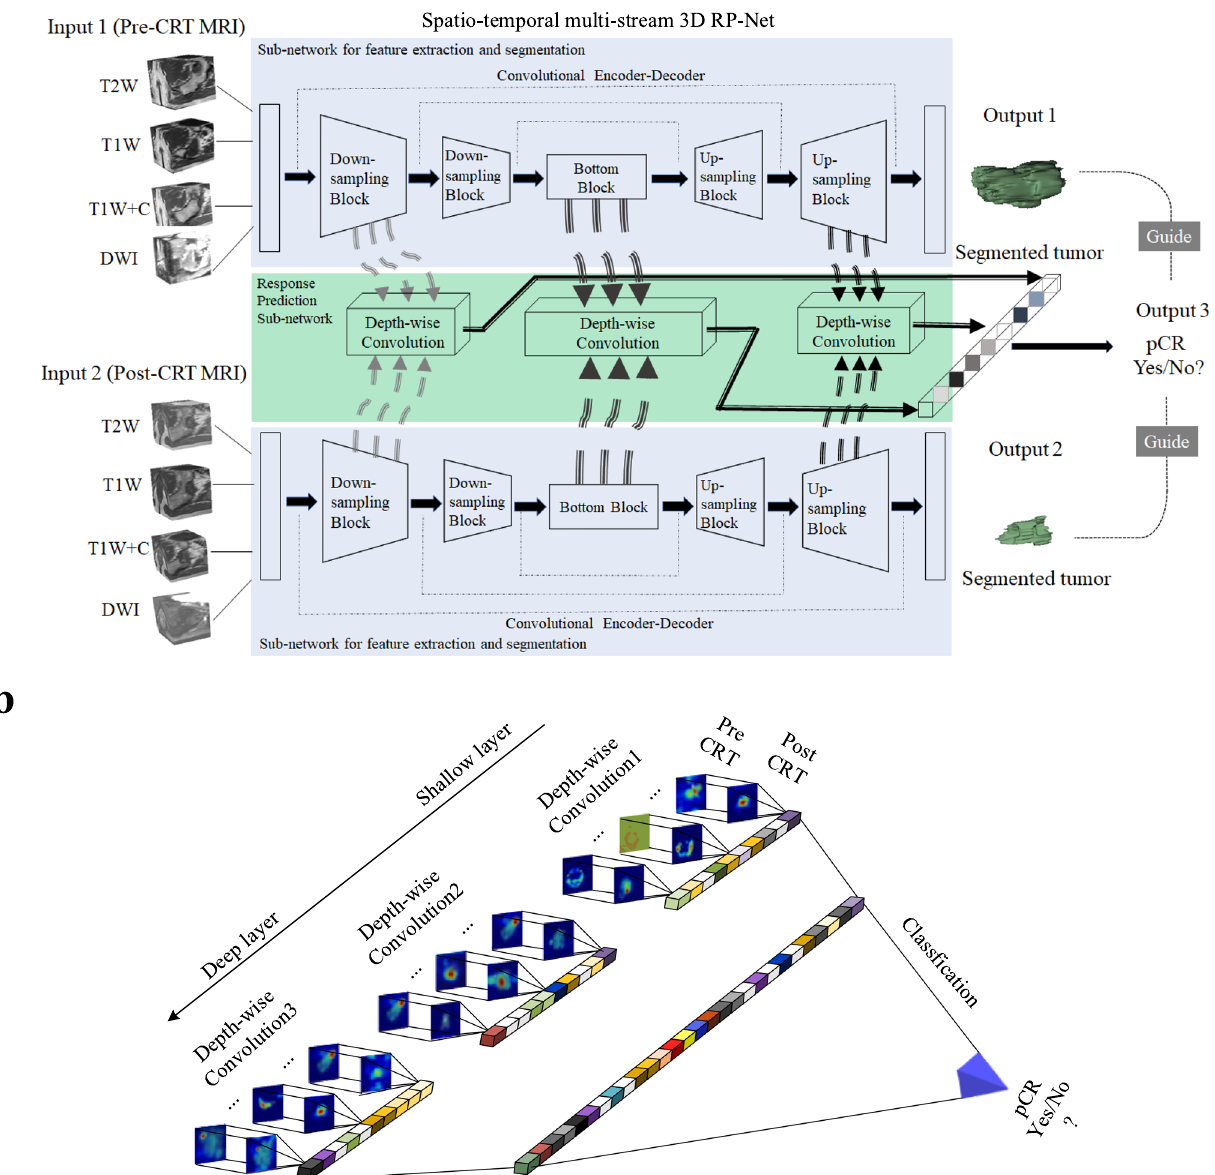
Fig. 2 Proposed network model for response prediction (3D RP-Net). a The multi-task deep learning network consists of two subnetworks: one for feature extraction and tumor segmentation, and one for response prediction. The network takes pre- and post-therapy images as inputs and performs two tasks simultaneously: tumor segmentation and response prediction. b Depth-wise convolution of pre- and post-therapy images at multiple network layers for multi-scale feature integration and response